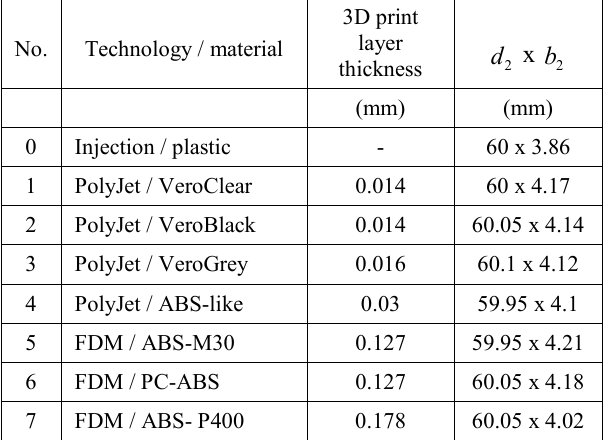
Table 1. Tested wheels, technology, material and